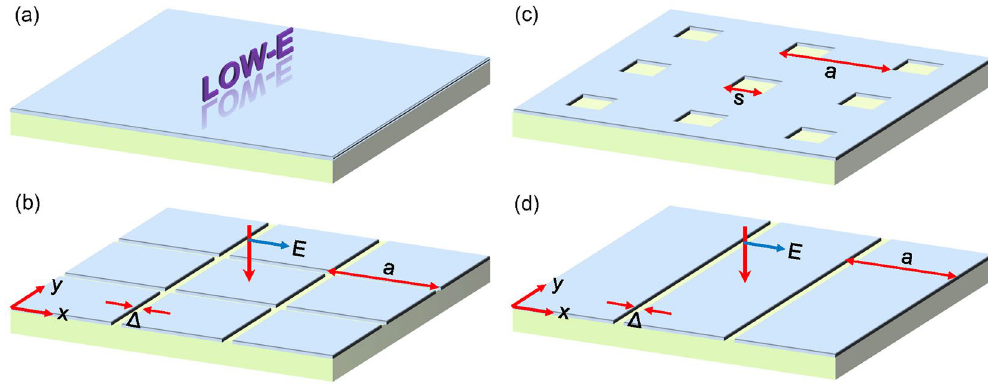
Figure 1. Redesign of low-e materials by using metasurfaces. ( a ) Schematic of ordinary low-e materials that is a substrate covered by a metallic film. ( b , c ) The same as ( a ) but with the metallic film designed to be of an air- connected and metal-connected pattern, respectively, in which a is the periodicity, Δ is the width of air slit, and s is the size of the air hole. The thicknesses of the metallic coating and the substrate are t 1 and t 2 , respectively. ( d ) The same as ( b ) but with the metal patches replaced by metal stripes. The structures in ( b , d ) have almost the same transmission for normal incidence with the E -field in the x